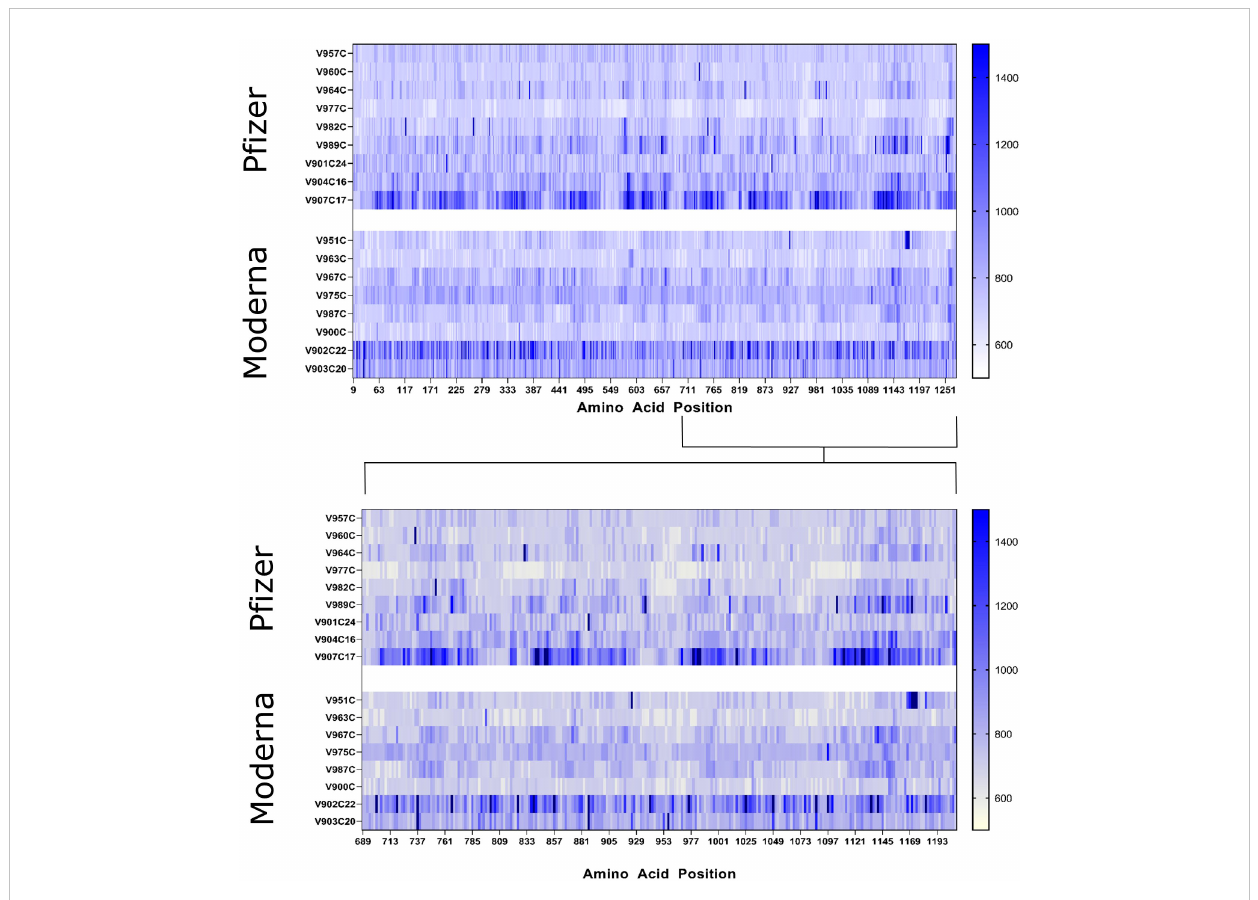
FIGURE 3 Heat maps of the whole SARS-CoV-2 spike protein (top) and S2 region (bottom) displaying the raw fl uorescent intensity values of vaccinated samples were created to compare epitope binding of Moderna and P fi zer vaccinated individuals. The fl uorescent intensity values were read at the 785 nm wavelength, which corresponds to IgG binding activity. Sample IDs are displayed to the left of their respective rows. Individuals who received the P fi zer vaccine are displayed in the upper panels while those who received the Moderna vaccine are found in the lower panels. The amino acid sequence of the entire spike protein is displayed in a linear manner with amino acid positions denoted